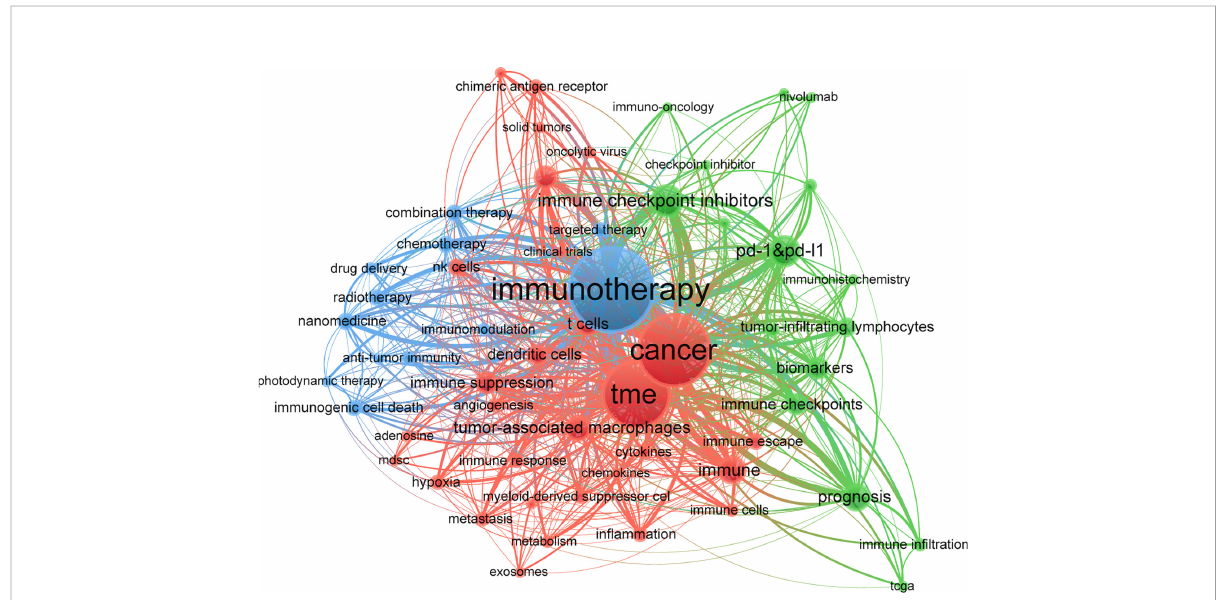
FIGURE 8 Keyword co-occurrence net and clusters in immunotherapy-TME studies (T ≥ 60; 59 items, 3 clusters, 1198 links; maxlines = 600). Note: The node and word size re fl ect co-occurrence frequencies, the link indicates co-occurrence, and the node color indicates the cluster.